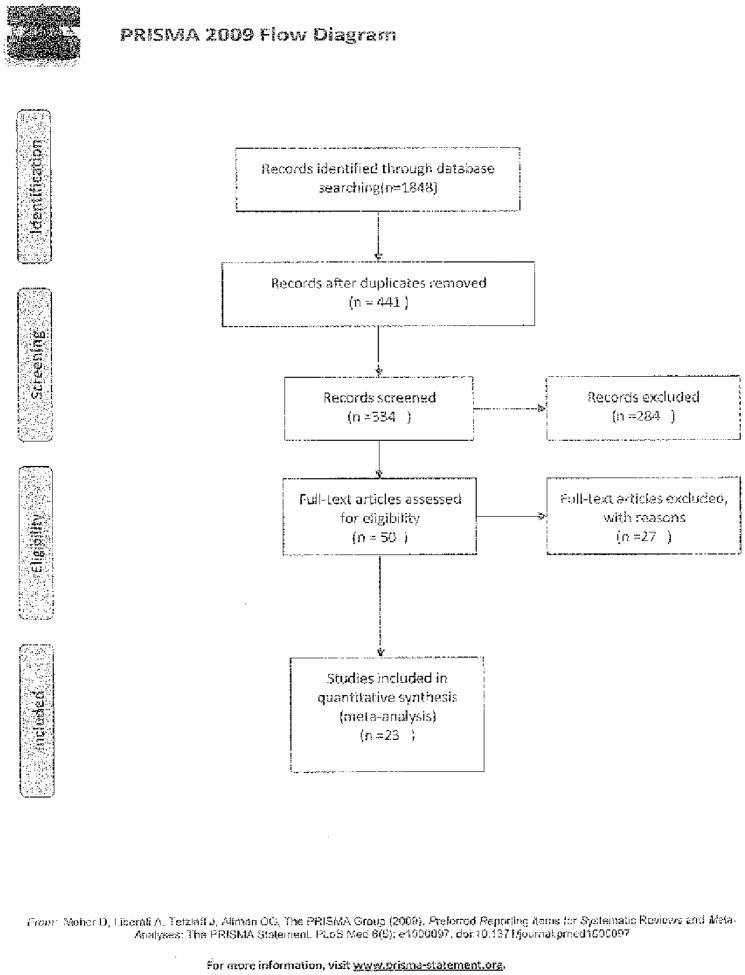
Prisma flow diagram.